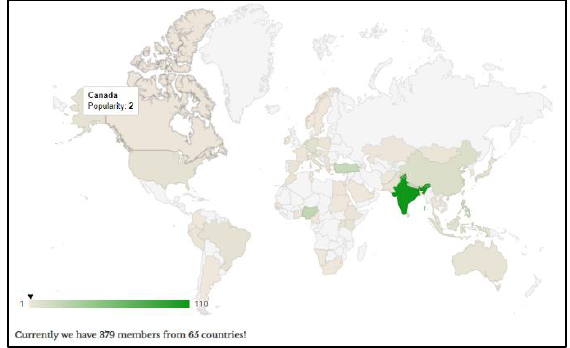
Figure 8 . The members map available in the official ISPRS SC website (http://sc.isprs.org/members/members-map.html) indicating the geographic distribution of the organization’s membership.